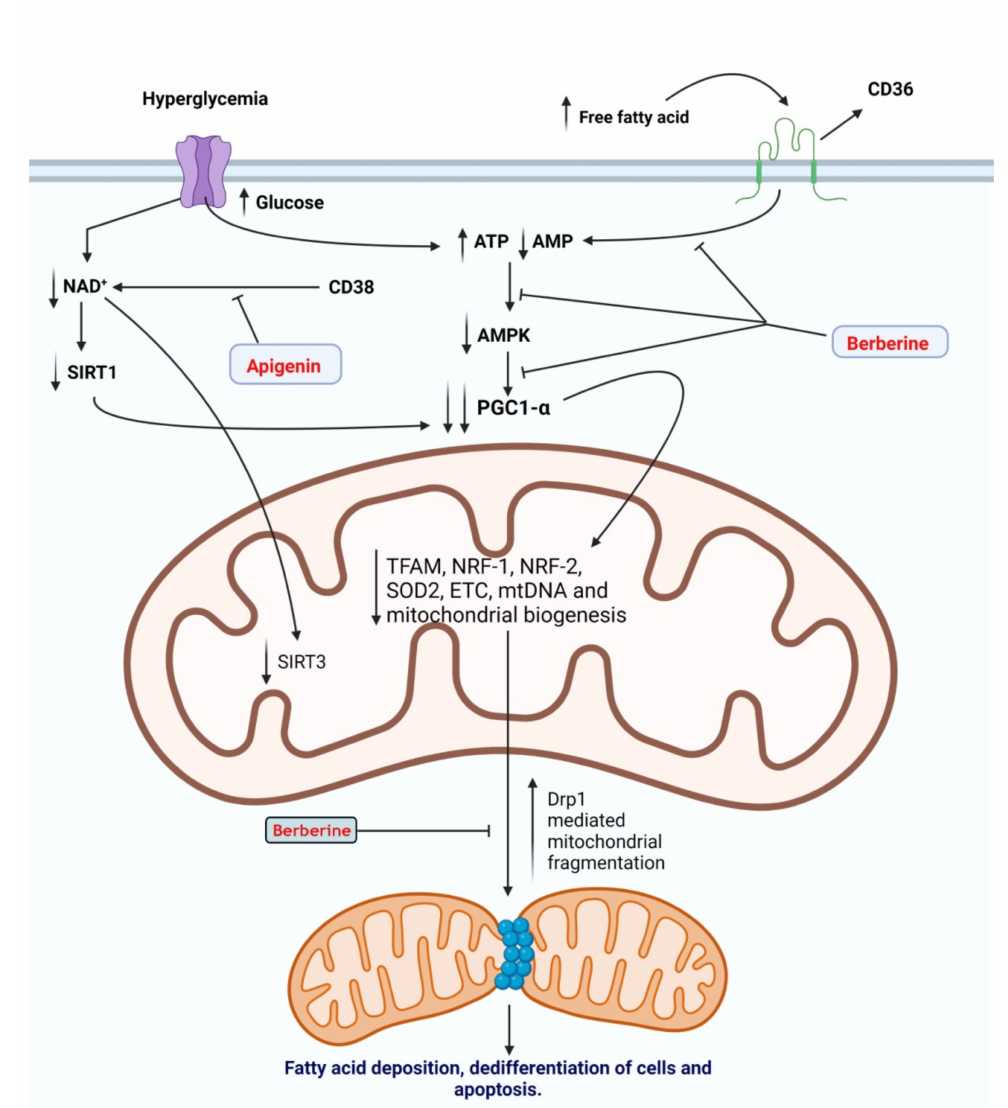
Figure 3. Medicinal plants and bioactive compounds that increase mitochondrial bioenergetics and prevent mitochondrial dysfunction. Hyperglycemia is accompanied by an increase in oxidative phosphorylation, leading to an increase in the adenosine triphosphate (ATP) to adenosine monophos- phate (AMP) ratio and a reduction in nicotinamide adenine dinucleotide (NAD + ): nicotinamide adenine dinucleotide hydrogen (NADH + ) ratio. Reduction in AMP and NAD leads to inactivation of activated protein kinase (AMPK) and sirtuin-1 (SIRT1), respectively. This, in turn, leads to the inhibition of peroxisome proliferator-activated receptor-gamma coactivator -1 α (PGC1- α ), the master regulator of mitochondrial biogenesisSimilarly, an increase in free fatty acids (FFA) levels activates a cluster of differentiation 36 (CD36), leading to the inactivation of AMPK and PGC1- α . Reduced mitochondrial biogenesis leads to recruitment of cytosolic Drp1 to the outer mitochondrial membrane and an increase in mitochondrial fission. Consequently, mitochondrial fragmentation leads to a reduction in fatty acid oxidation and accumulation of FFA, leading to dedifferentiation of renal cells and apoptosis. Berberine inhibits the inactivation of AMPK and the recruitment of dynamin-related protein1 (Drp1) to the mitochondrial membrane. Thus, maintaining mitochondrial biogenesis and bioenergetics and preventing mitochondrial dysfunction that results from hyperglycemia and the increase in levels of FFA. Apigenin inhibits CD38-mediated consumption of NAD, thus preventing the inactivation of sirtuin-1 (SIRT1) and sirtuin-3 (SIRT3).